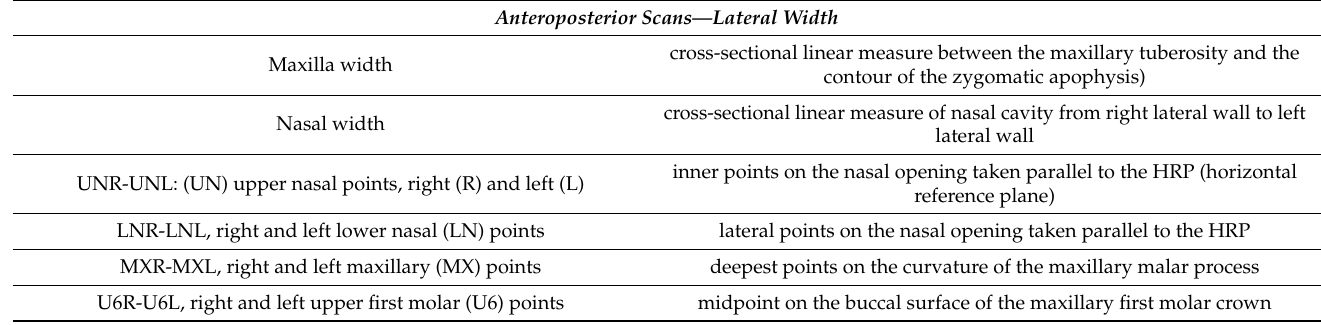
Table 1. Effects of RME on airway dimensions and volume: anteroposterior scans vs. lateral